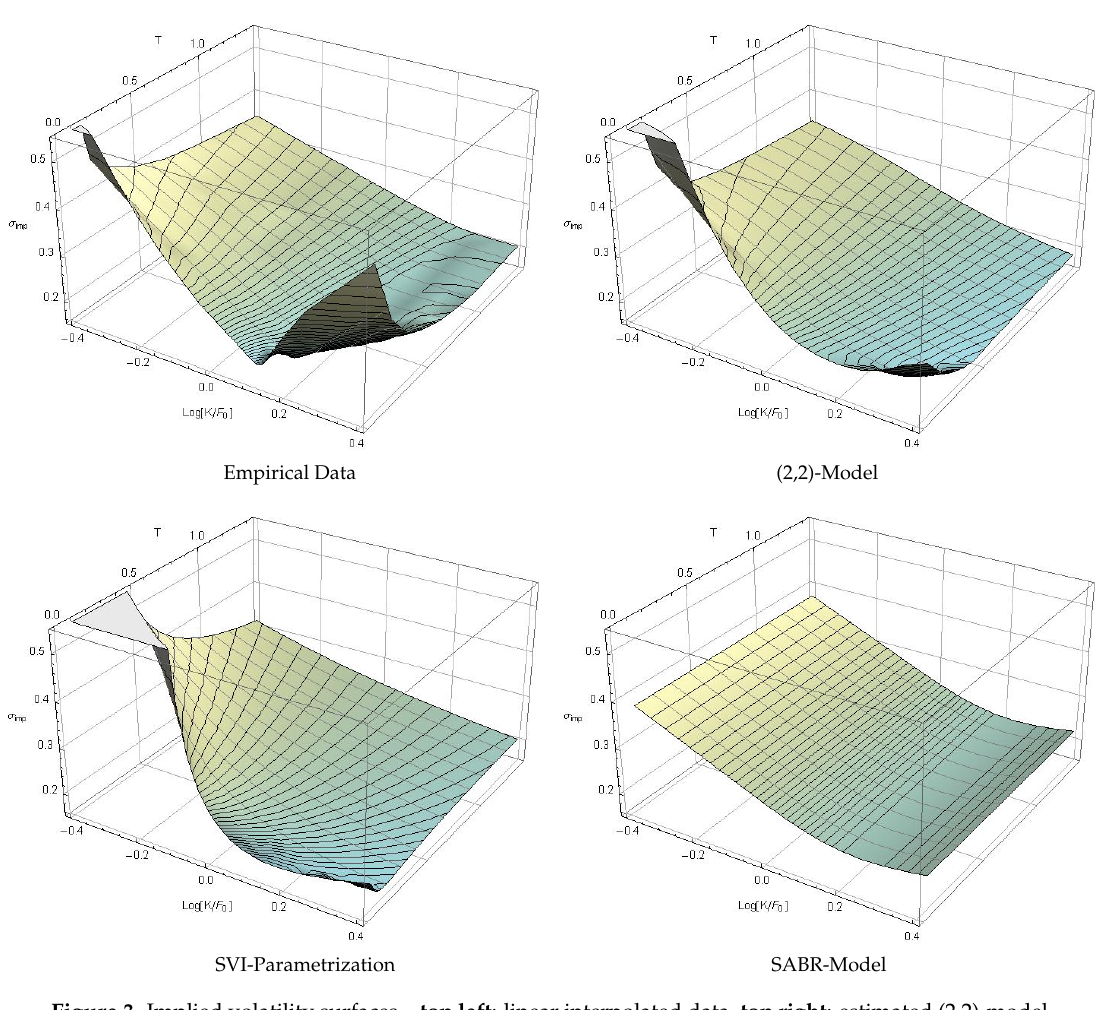
Figure 3. Implied volatility surfaces— top left : linear interpolated data, top right : estimated (2,2)-model, bottom left: stochastic volatility inspired (SVI) parametrization, bottom right: SABR